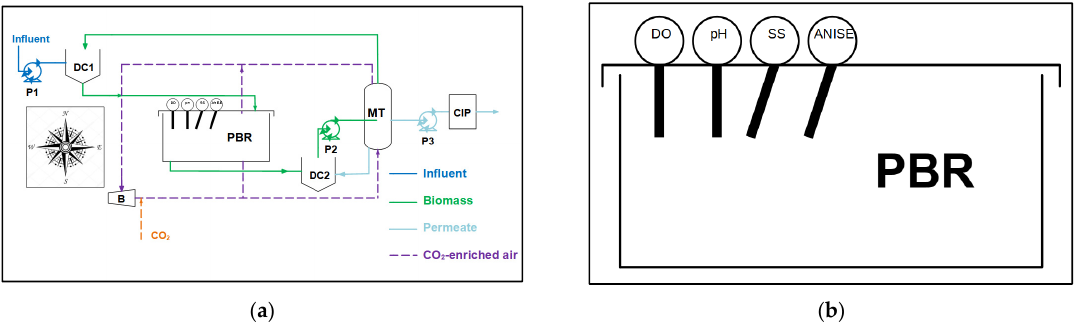
Figure 1. ( a ) Outdoor MPBR system scheme. ( b ) Detail of probe locations.